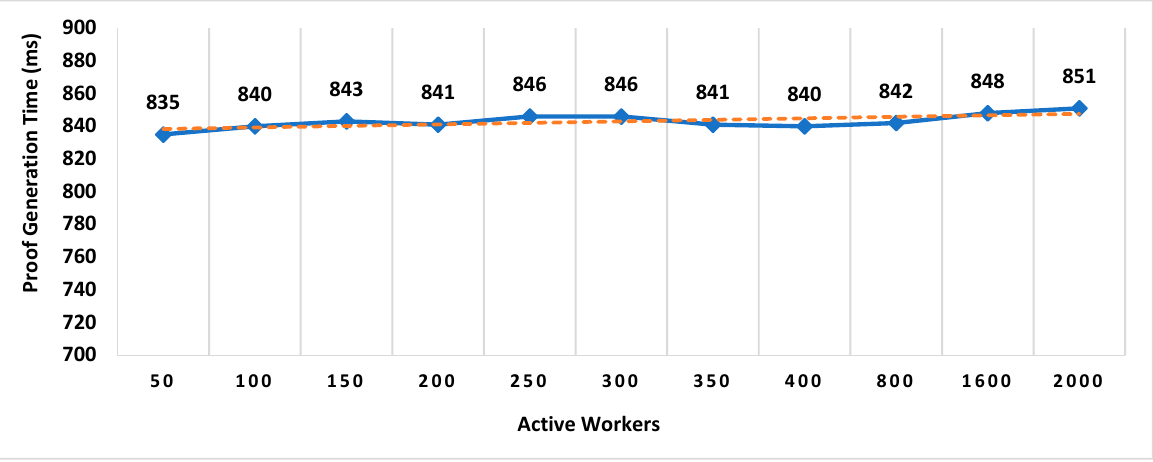
Figure 4. Impact of the number of active workers on the proof generation time.